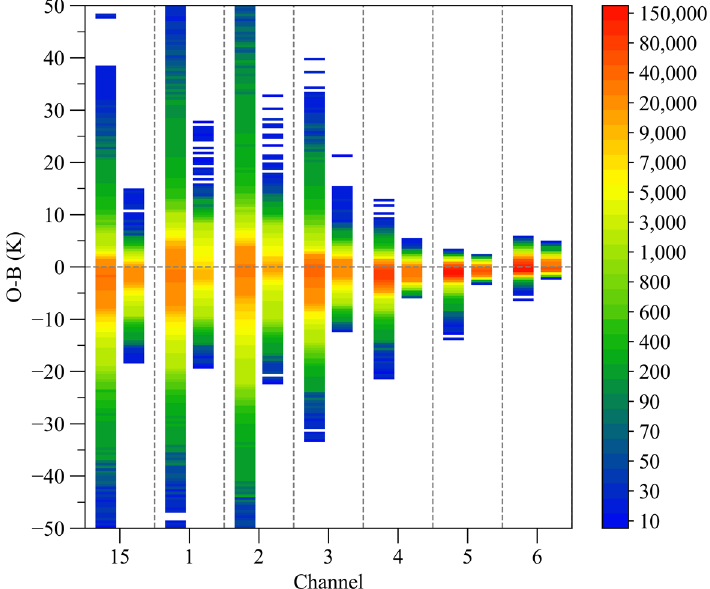
Figure 9. Distribution of data volume in di ff erent O − B intervals (interval: 1 K) before (left-hand side) and after (right-hand side) removal of cloudy observations for AMSU-A channels 1–6 and 15 from NOAA-19 from June to August 2019, with the colors representing the data volume.